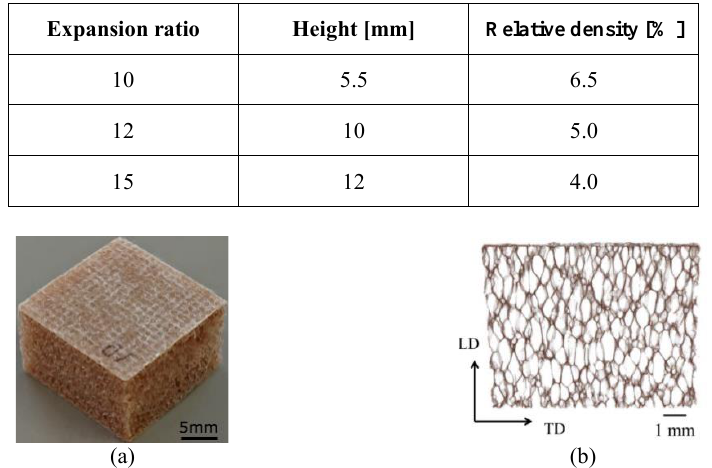
Table 1. Geometric parameters of the material used in the study [4].